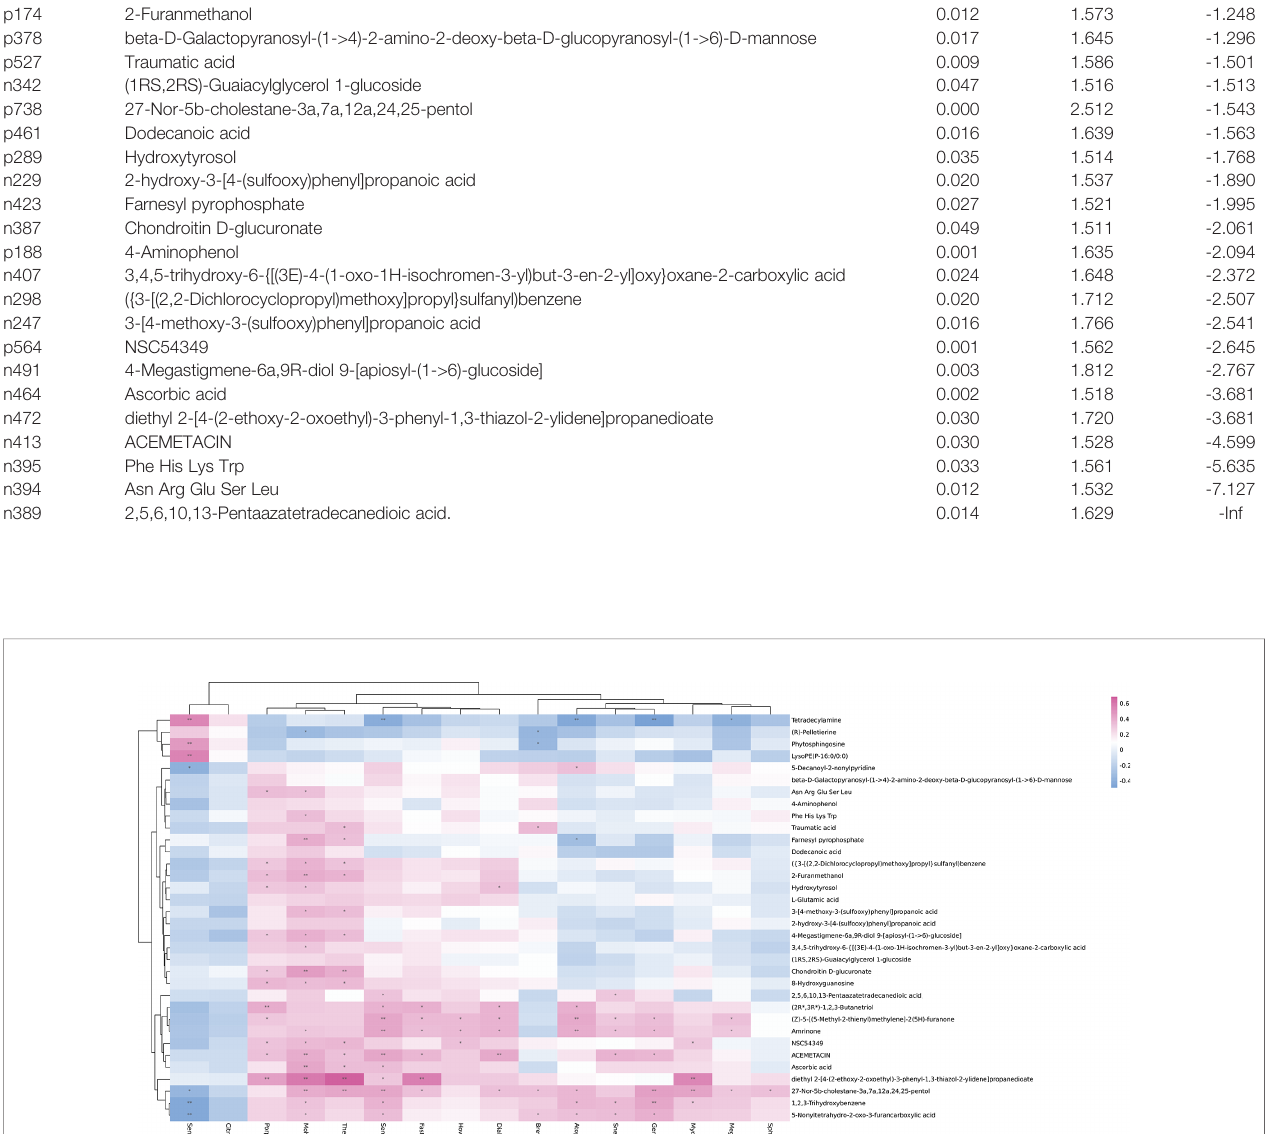
Frontiers in Cellular and Infection Microbiology |